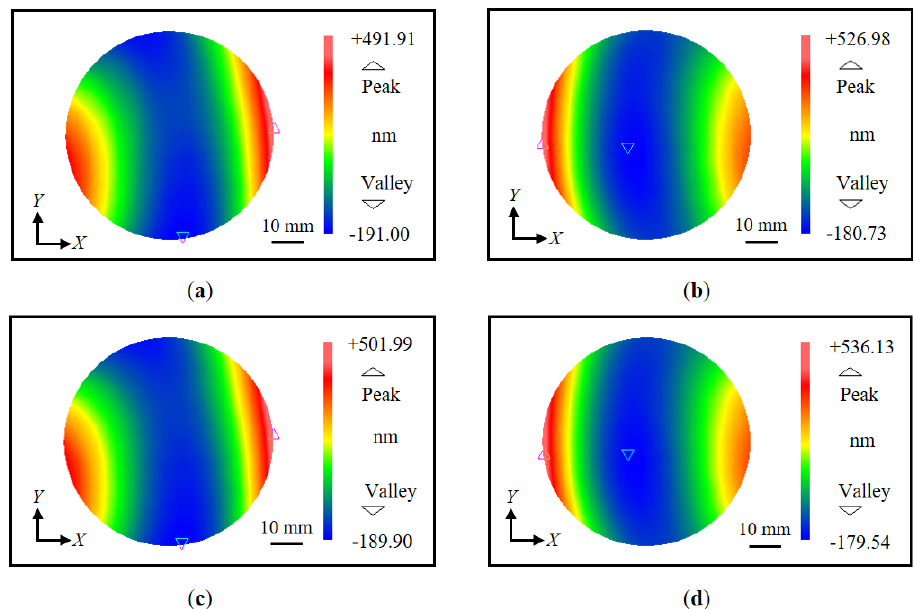
Figure 14. Measured diffracted wavefronts before and after shift ( Y -direction): ( a ) Measured positive first-order diffracted wavefront before the shift; ( b ) Measured negative first-order diffracted wavefront before the shift; ( c ) Measured positive first-order diffracted wavefront after the shift; ( d ) Measured negative first-order diffracted wavefront after the shift.